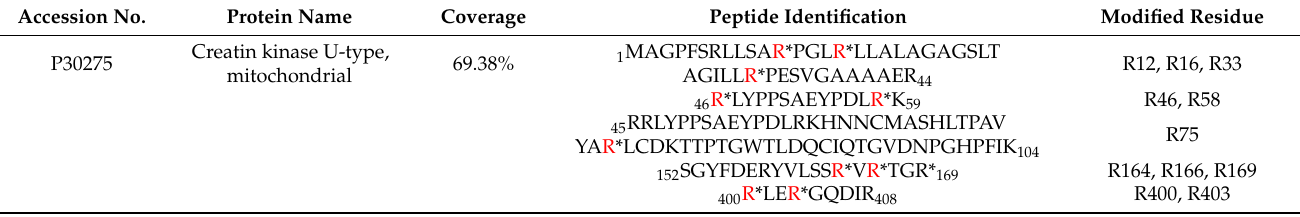
Table 2. LC-MS/MS analysis of MG-H1 modification in mitochondrial Creatine kinase purified from HIP of KO/VB6( − ) mice